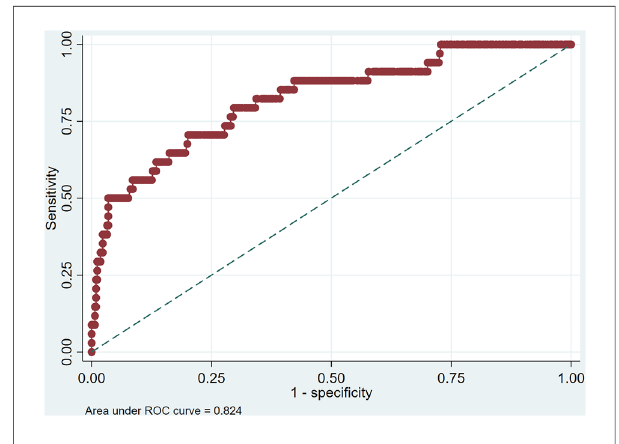
FIGURE 4 Receiver operating characteristic (ROC) curves of the multivariate logistic regression.